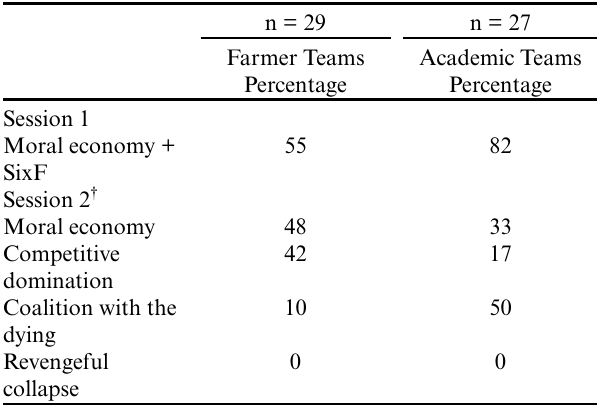
Table 2 . Frequencies of different social preferences displayed by farmers and academics in sessions 1 and 2.